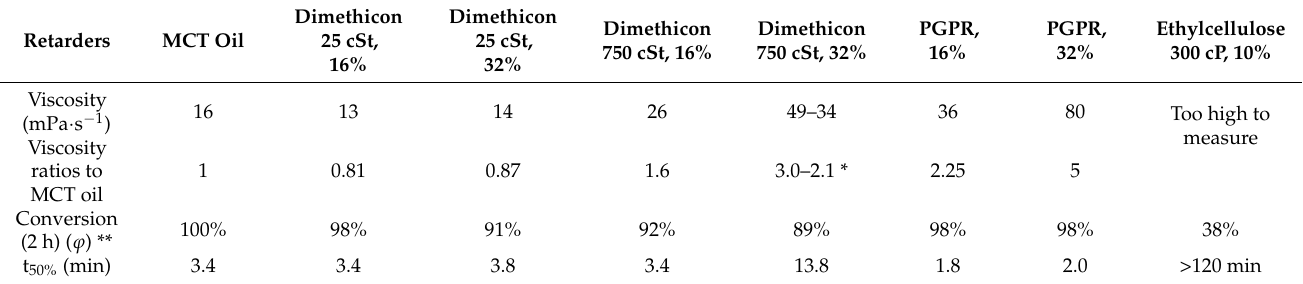
Table 3. The viscosities of different formulations after pre-emulsification: dimethicon 25 cSt 16% and 32%, dimethicon 750 cSt 16% and 32%, PGPR 16% and 32%, ethylcellulose 300 cP, 10%.